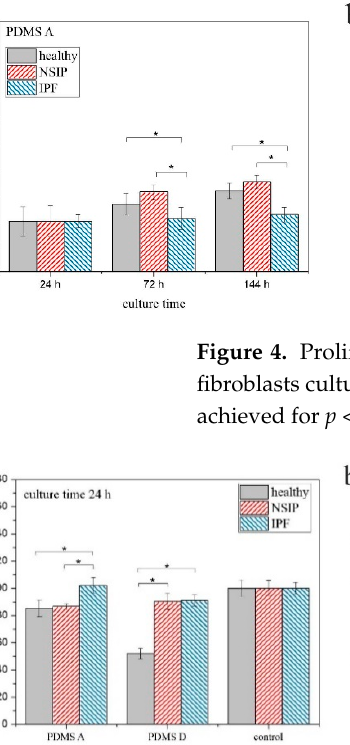
Figure 3. Fluorescence micrographs of the actin cytoskeleton (green) and nuclei (blue), recorded for IPF-derived fibroblasts cultured for 24 ( a – c ), 72 ( d – f ), and 144 h ( g – i ) on PDMS A ( a , d , g ), PDMS D ( b , e , h ), and control samples (glass, ( c , f , i )).